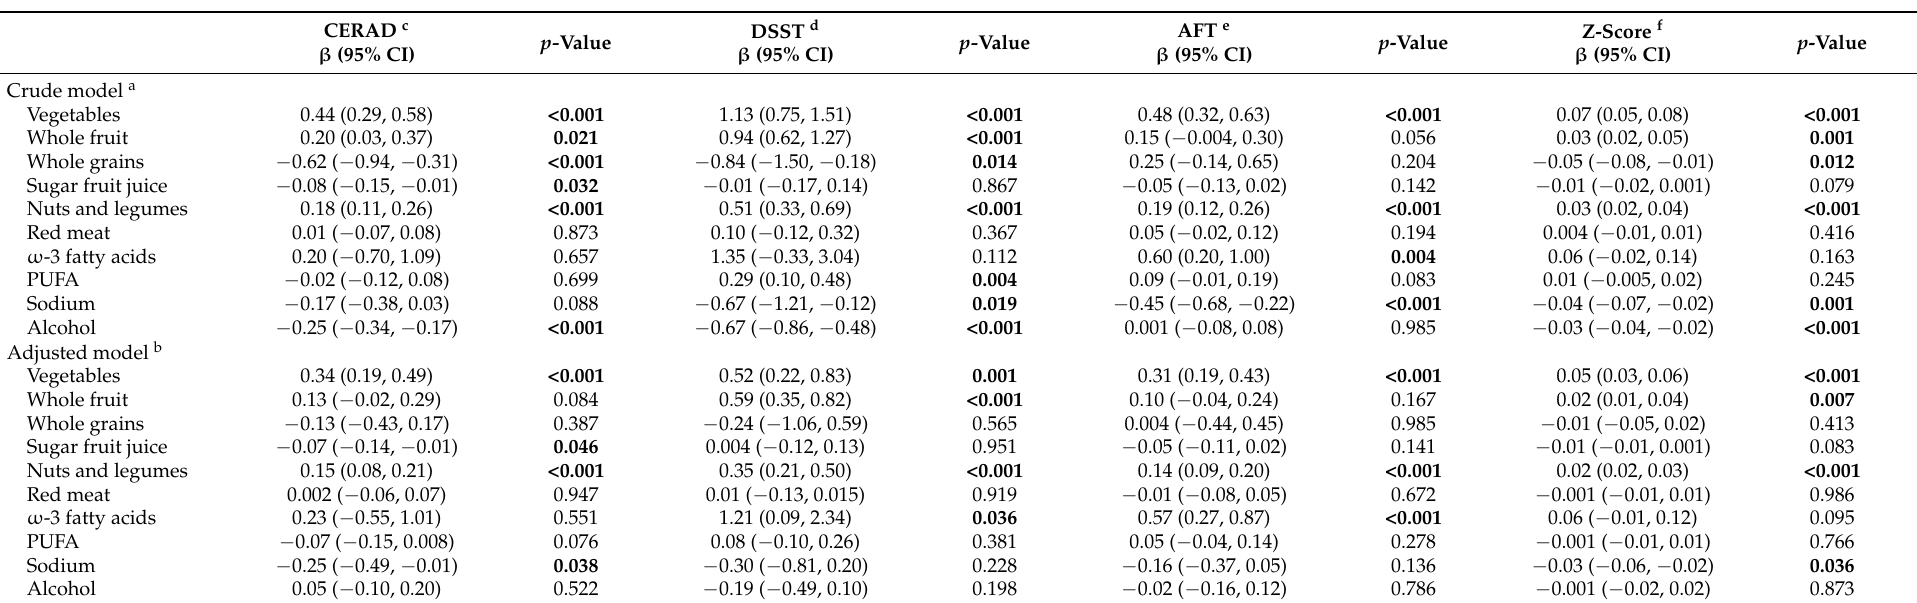
Table 4. Associations of AHEI-2010 components with cognitive function: NHANES: 2011–2014( n = 2644).